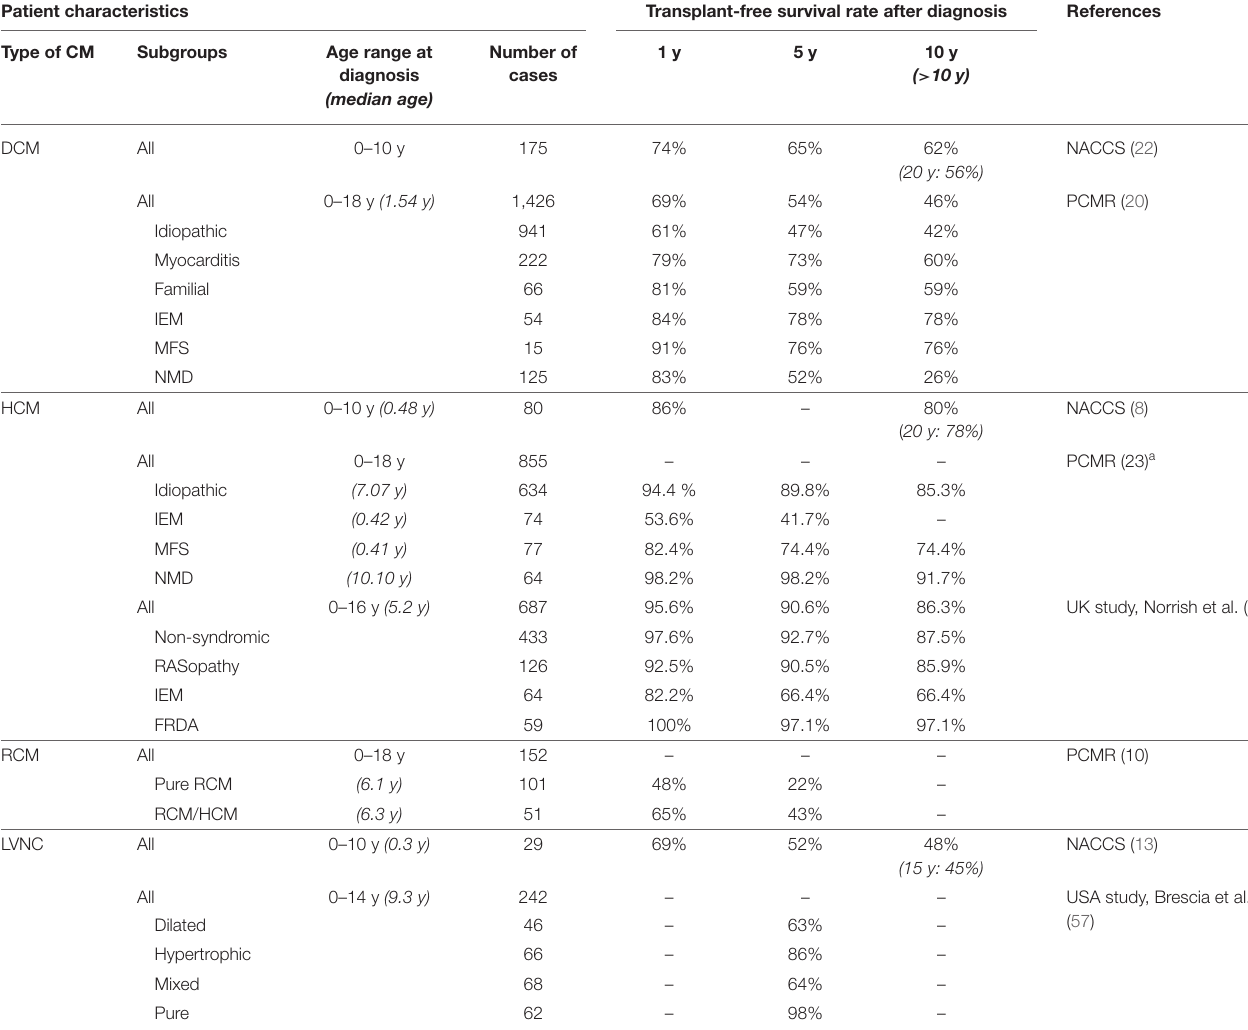
TABLE 2 | Transplant-free survival for each type of cardiomyopathy